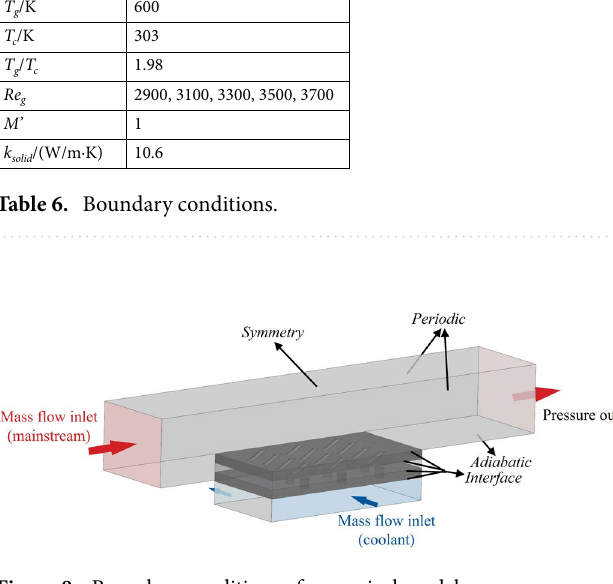
Figure 8. Boundary conditions of numerical